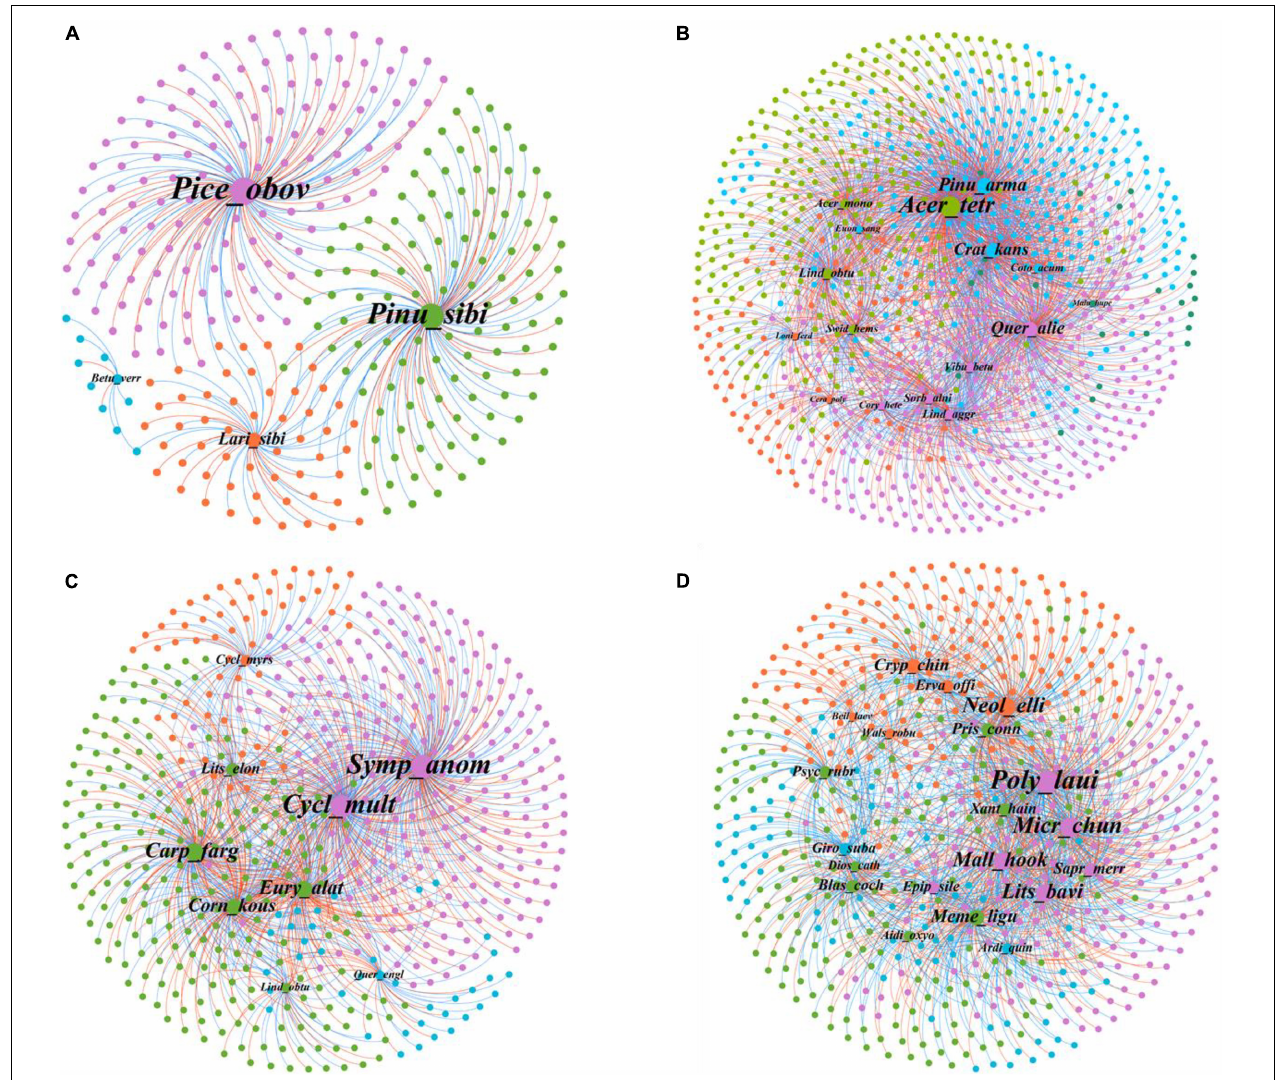
FIGURE 3 | The plant–bacteria network architecture. (A) Kanas (KNS); (B) Gansu (GS); (C) Mulinzi (MLZ); (D) Hainan (HN). For each network, plants and microorganisms within the same module are indicated in the same color while different colors represent different modules. Node size are associated with node